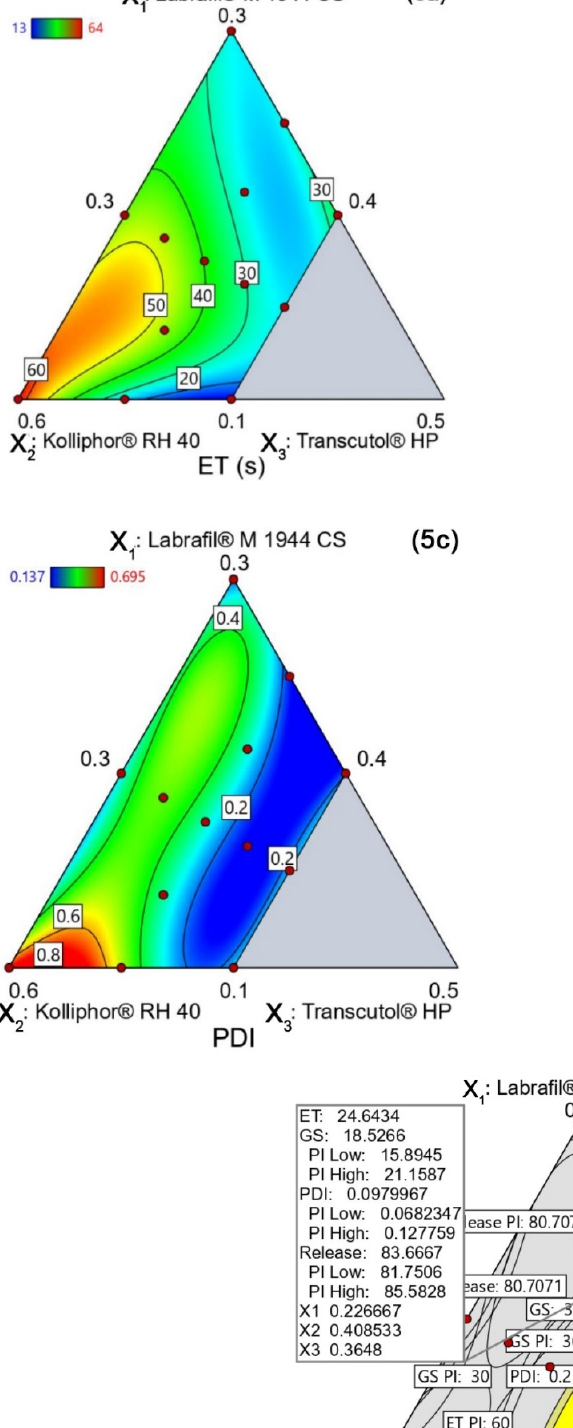
According to the equation and contour plot (Figure 4c), the PDI value increased with each component (Table 3). However, the PDI decreased when at least two of the three components were used together. However, the PDI value increased as more Kolliphor ® RH 40 was used and decreased when the Transcutol HP increased, possibly due to the latter’s strong surface-active properties that thoroughly homogenize the mixture. How- ever, Labrafil ® M 1944 CS did not significantly change the PDI value when its concentra- tion was increased. The possible explanation could be that Kolliphor ® RH 40 increases the ‘Ostwald Ripening Rate’ where the smaller particles contract and the larger particles be- come more significant, increasing the PDI. This phenomenon is further explained by Lia Zeng [49]. 4.5.4. Release (Y Release ) Y Release = 61.71 X 1 + 78.78 X 2 − 299.20 X 3 + 64.22 X 1 X 2 + 817.51 X 1 X 3 + 802.13 X 2 X 3 − 1153.47 X 1 X 2 X 3 + 44.95 X 1 X 2 (X 1 − X 2 ) − 554.43 X 1 X 3 (X 1 − X 3 ) − 557.28 X 2 X 3 (X 2 − X 3 ) The polynomial equation and contour plot (Figure 5d) confirmed that the formula- tions rich in Labrafil M 1944 CS had the least drug release in 24 h (Table 4). On the other hand, the percentage of drug release from formulations rich in Transcutol HP was signif- icantly higher. However, since both follow a cubic type response, the drug release is com- paratively lower in extreme concentrations of Transcutol HP. This data shows that drug release was related to droplet size in an inverse relationship; the percentage of drug re- lease was increased when the droplet size was reduced. Furthermore, all the formulations in the experiment formed droplets in the range of 18–40 nm. They are easily permeable through the intestinal membranes through cellular pores through passive diffusion [50].